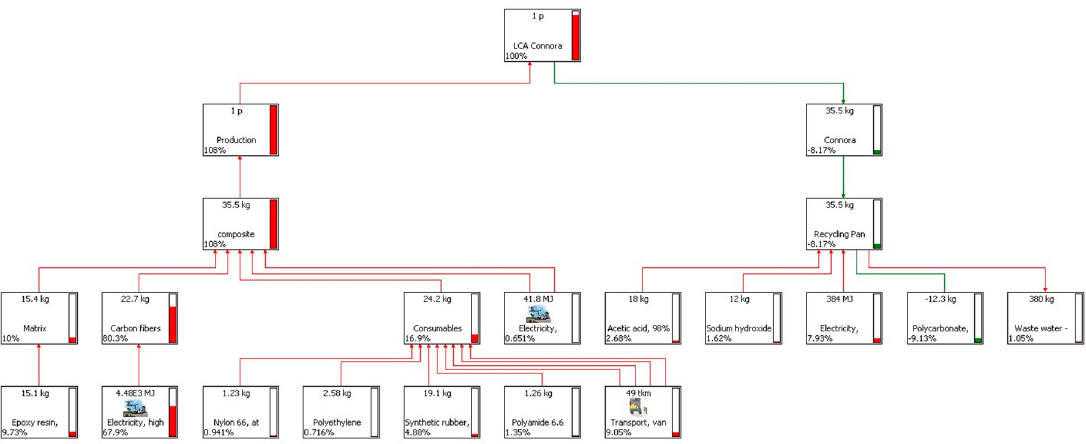
Figure 8. LCA diagram of the production and recycling of the CF-laminate. Scenario (b): the CFs are recovered as PAN and need further treatment to be re-used as CFs.